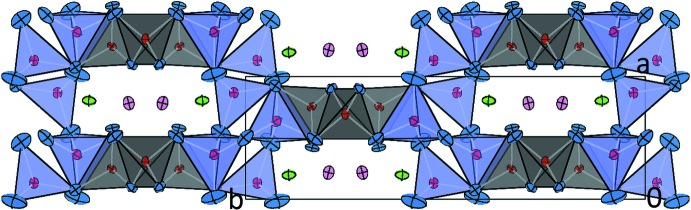
Projection of the crystal structure of Ca3CoAl4O10 in a view parallel to [001]. Displacement ellipsoids as in Fig. 1 ▸.